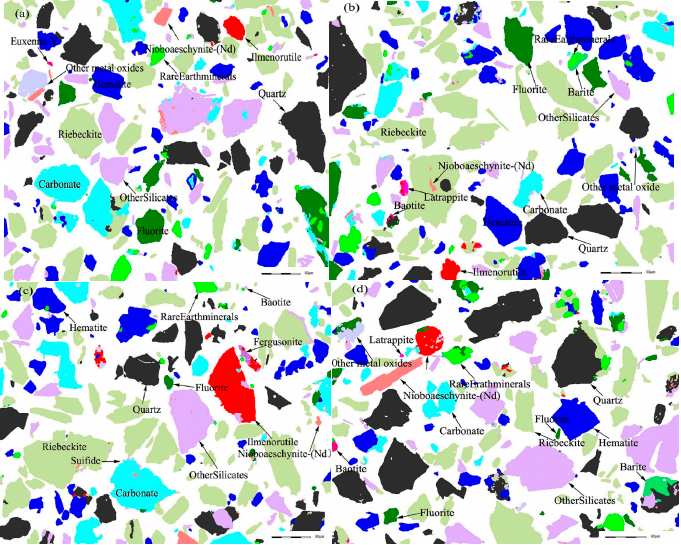
Figure 4. The types of minerals in the samples and the occurrence characteristics of niobium minerals. ( a ): Nioboaeschynite-(Nd) is associated with other silicate minerals and other metal oxides. ( b ): Ilmenorutile and nioboaeschynite-(Nd) are associated with riebeckite, and baotite is associated with quartz and rare-earth minerals. ( c ): Ilmenorutile is associated with other silicates and carbonate, and nioboaeschynite-(Nd) is encased in carbonates. ( d ): Ilmenorutile is associated with fluorite and other metal oxides.